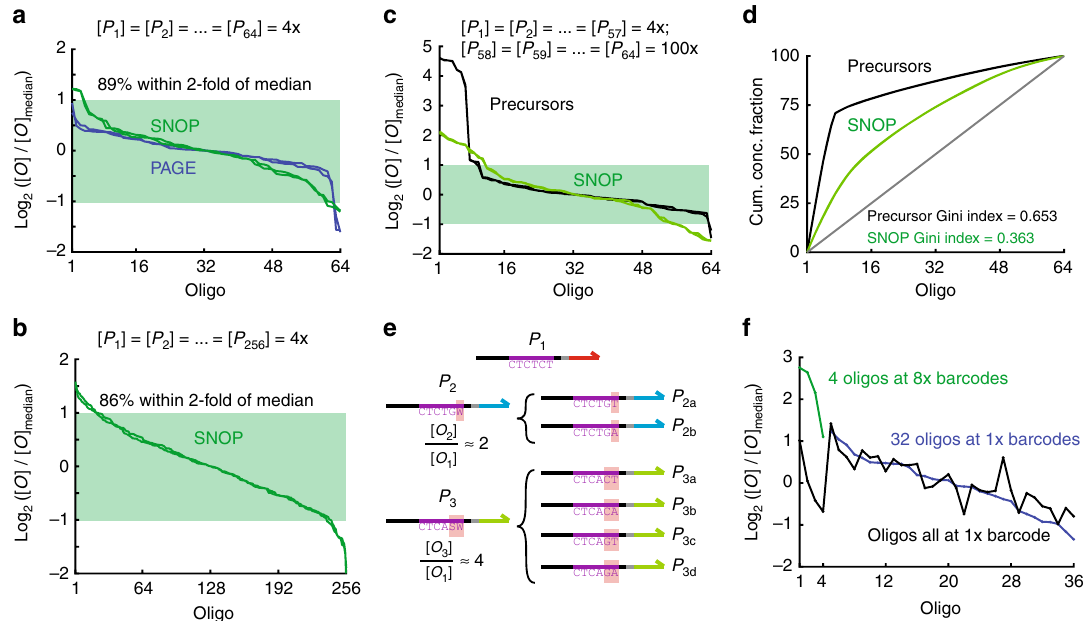
Fig. 5 SNOP product stoichiometry. a Distribution of 64-plex SNOP product concentrations inferred from NGS results. Precursors were purchased commercially as desalted oligos and all precursors were mixed together at equal concentrations as the SNOP input. The desalted oligo library was used for NGS normalization to determine concentration from reads count. There is slight bias in the SNOP product concentrations, with roughly 90% of oligos within 2-fold of median concentration. b Relative concentration distribution of 256-plex SNOP. c Effects of gross biases in precursor concentrations on SNOP product stoichiometry. Seven of the 64 precursors were at 25-fold higher concentration compared to the rest, and these are re fl ected in the higher concentrations of the top 7 species in NGS for the precursor library. The SNOP product library shows a more equal distribution of oligo product concentrations, though the more skewed precursor concentrations does result in a wider range of product concentrations. d Lorenz curve showing the cumulative concentration distribution of the SNOP products from grossly biased precursors. From this fi gure, we determined that the SNOP process reduces the Gini inequality coef fi cient from 0.65 to 0.36. e Advanced stoichiometry control of SNOP products. Using degenerate nucleotides in the barcodes of some precursors allows the relative concentration of those precursors ’ products to be controllably increased. f NGS reads for 36-plex SNOP, in which 4 of the precursors had 8x barcodes (3 degenerate nucleotides). The black trace shows corresponding relative concentrations for the same